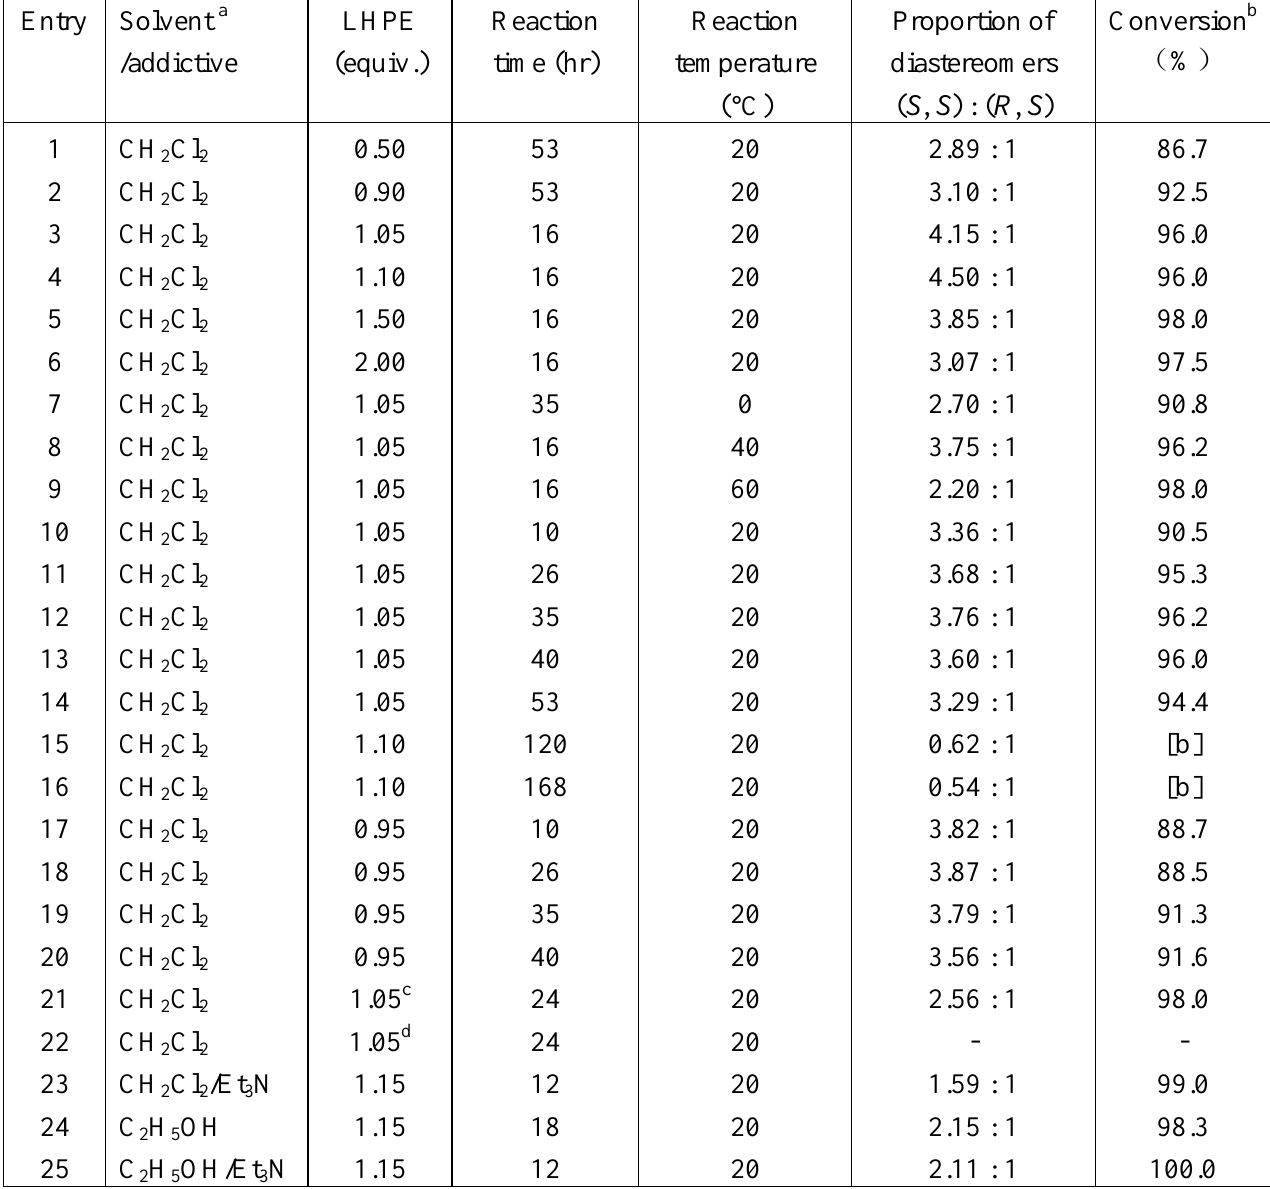
Table 2. The Variation of Reaction Conditions on the Aza-Michael